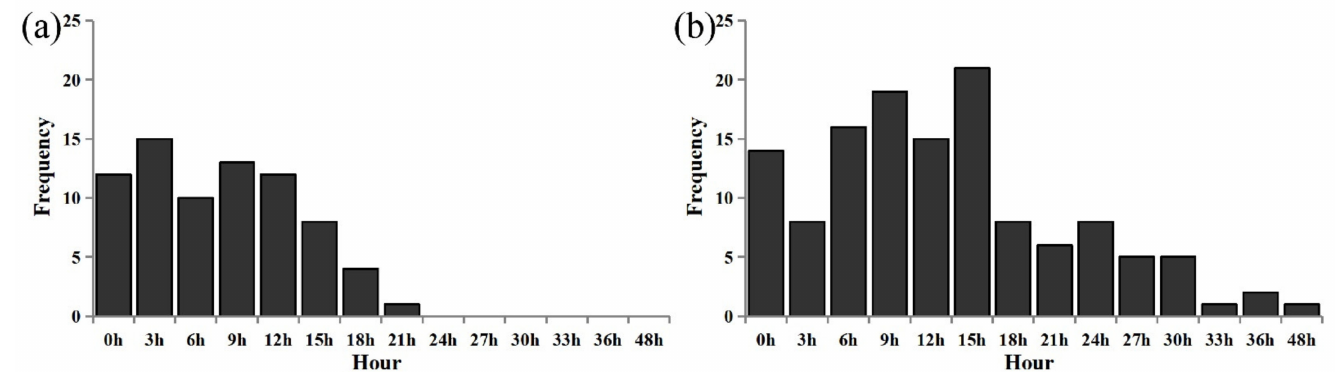
Figure 5. Frequency of the explosive-developing lifetime (in hours) for ECs over ( a ) the Japan Sea and ( b ) Kuroshio/Kuroshio